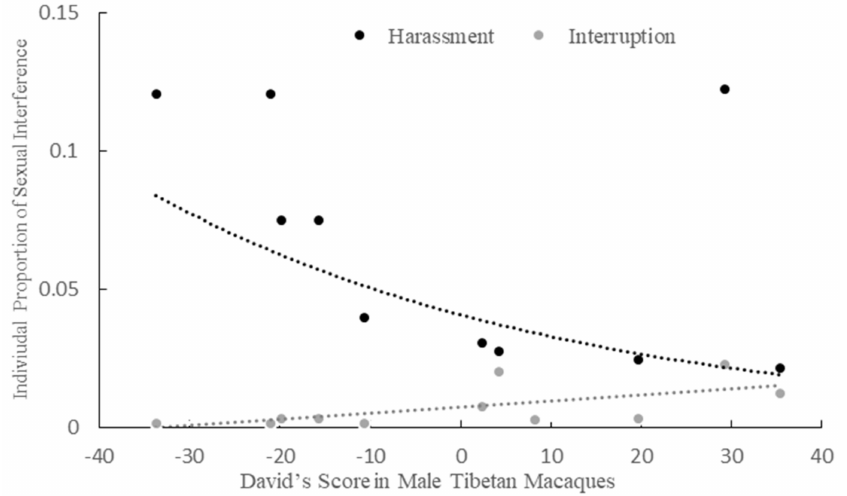
Figure 3. The relationship between adult and subadult male rank and the individual proportion of interruption or